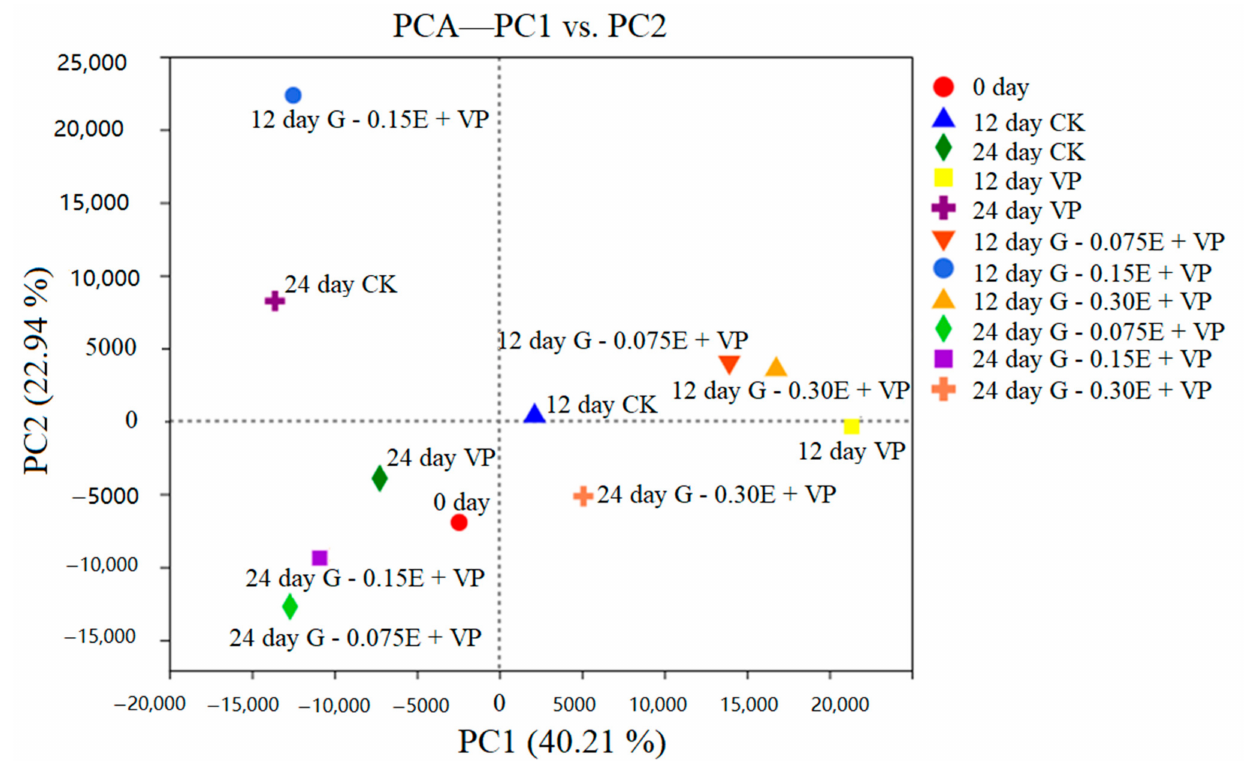
Figure 1. Results of principal component analysis at the genus level for each